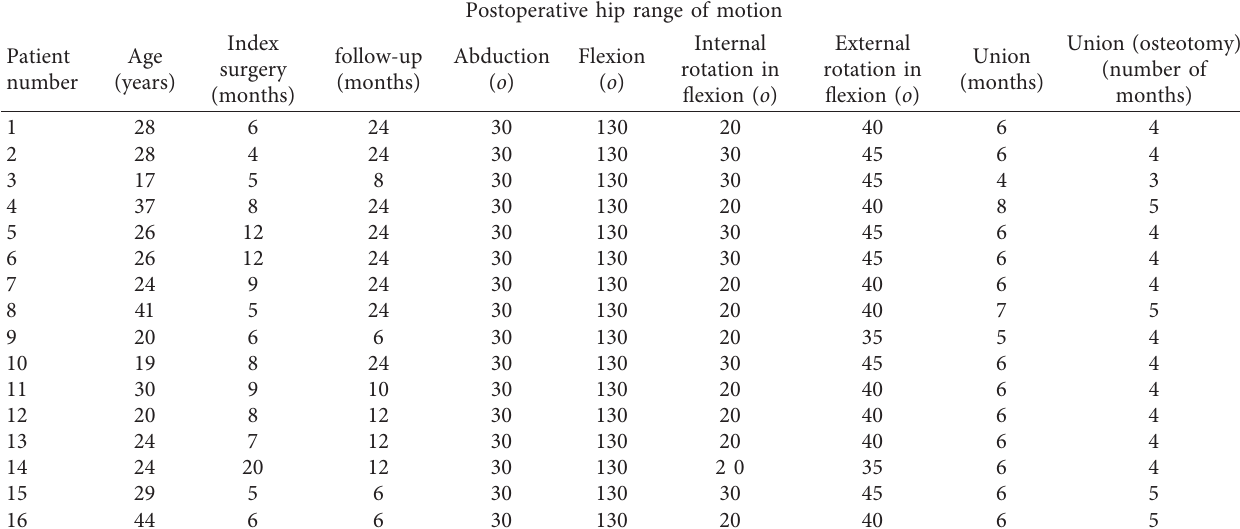
Table 1: Patients’ clinical